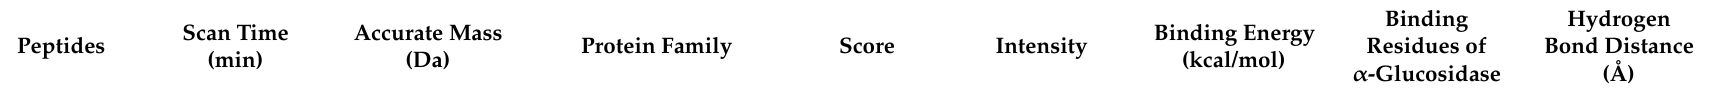
Table 1. Identification of peptides in rice bran fermentation products by LC-MS/MS and molecular docking analysis of their potential binding sites with α